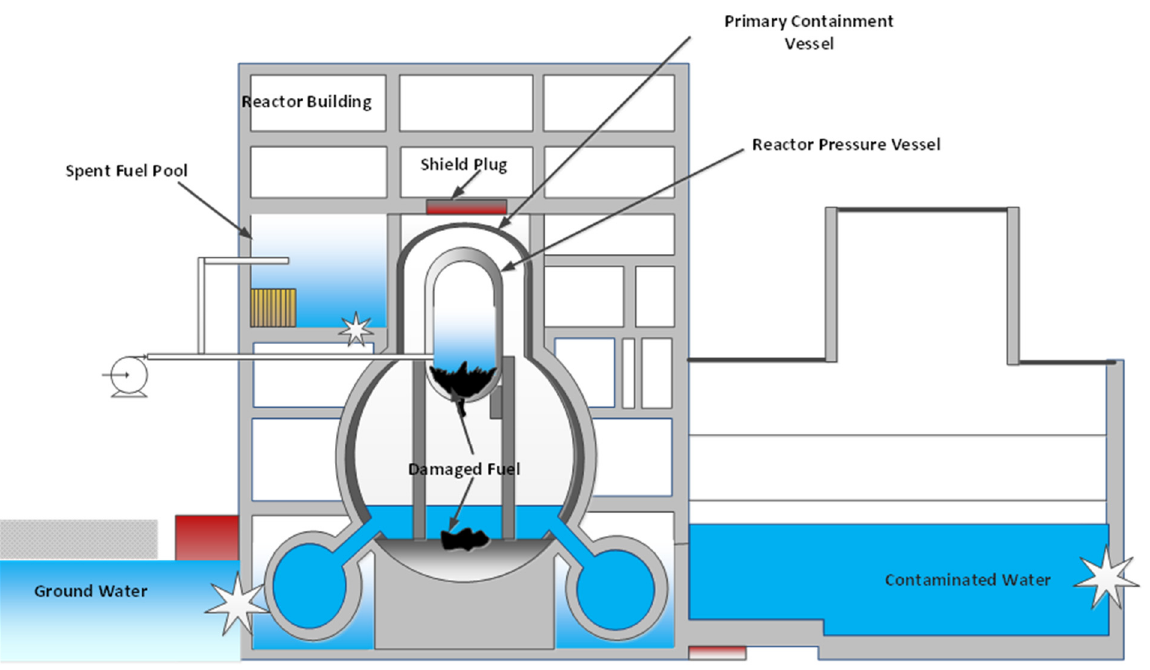
Figure 1. Current state of the Fukushima Dai ich nuclear reactor units 1, 2 and 3.